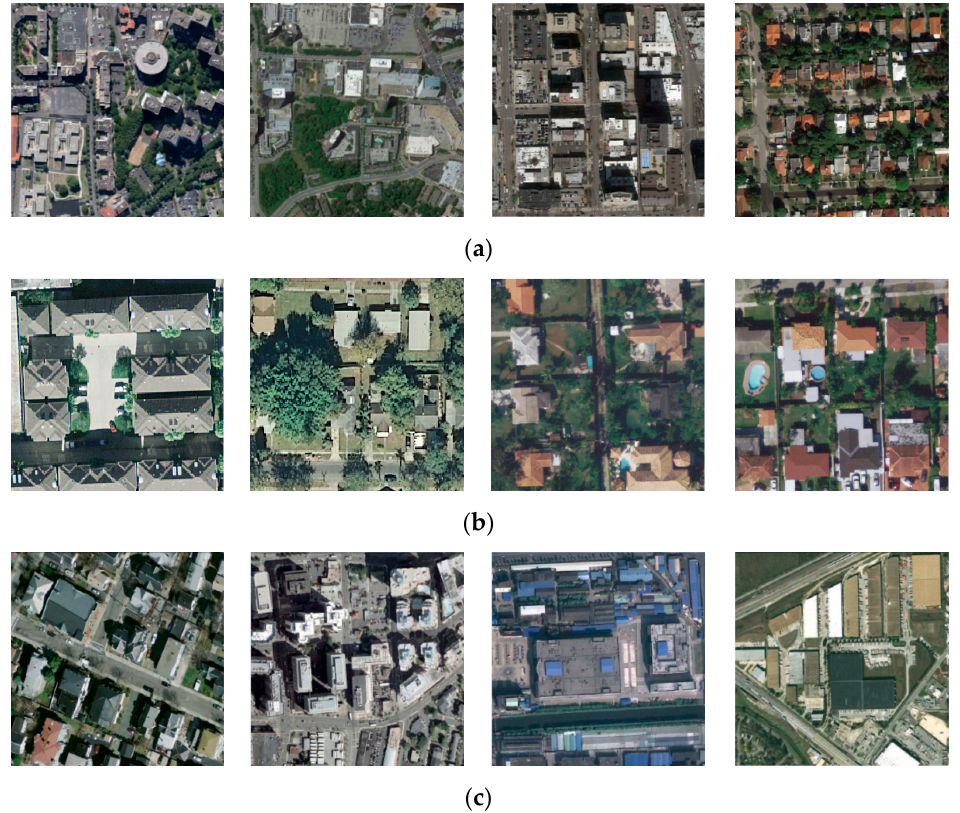
T TS . Figure 10. Examples of the testing image: ( a ) 3